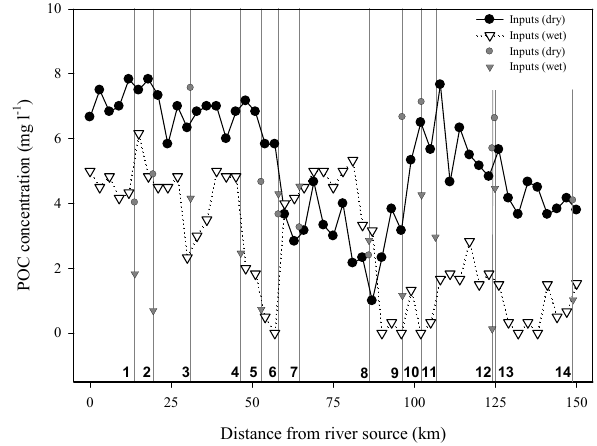
Distance from river source (km) Fig. 5. Fig. 5. POC concentration along the course of the River Sebangau during the dry and wet seasons. Vertical lines represent the conflu- ences of fourteen channels that discharge into the River Sebangau. Each confluence has an identification number above the x-axis (see Table 1). Single point data represent POC concentrations in each channel prior to discharge into the River